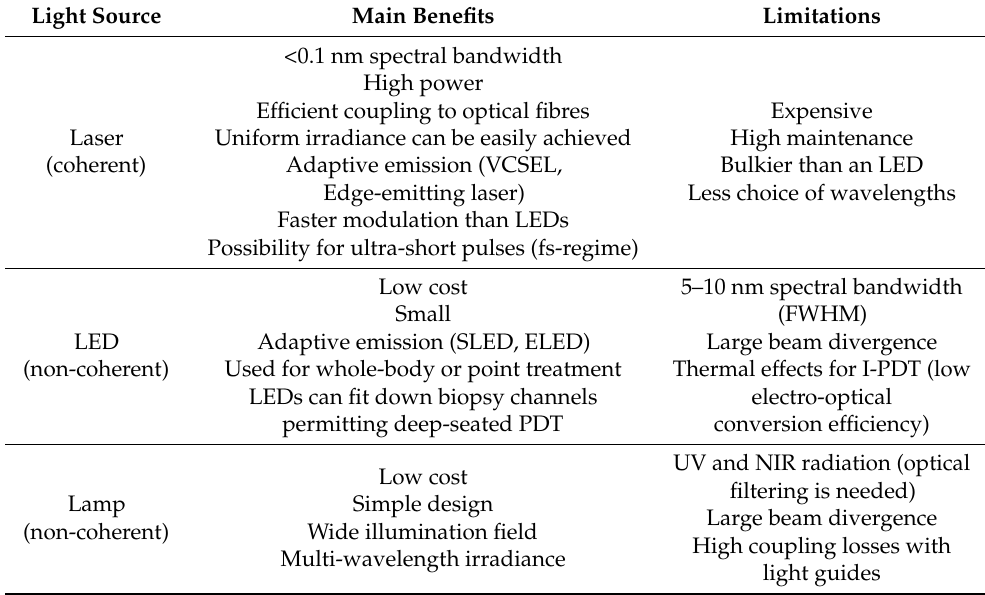
Table 1. Main benefits and limitations of coherent (laser) and non-coherent (LED, lamp) light sources in superficial PDT. The table is adapted from